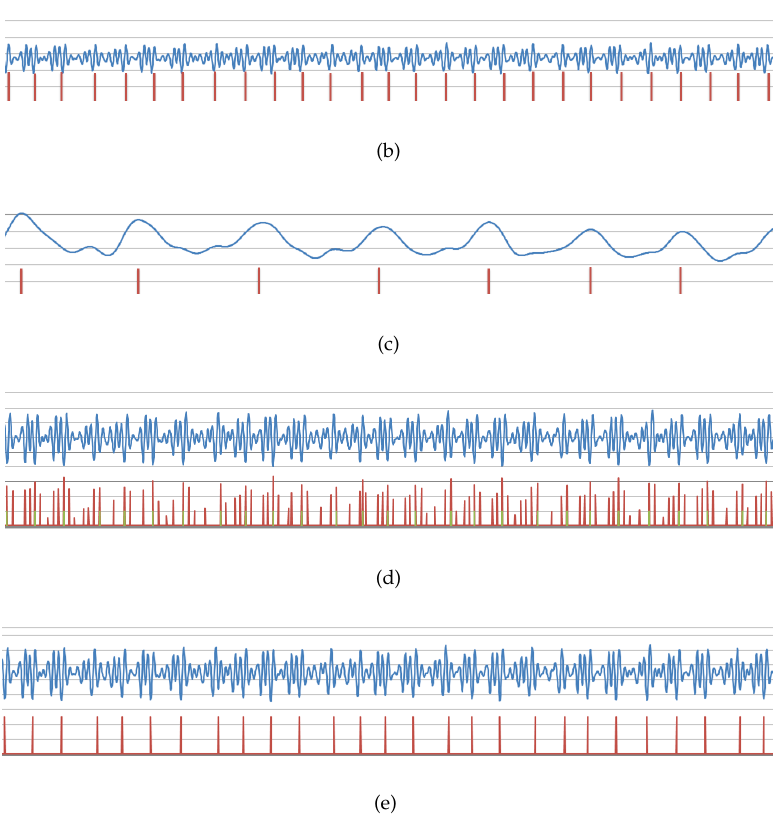
Figure 7. Heart rate variability and respiratory rate. ( a ) Raw data obtained from ADC (100 samples/s, 12-bit resolution); ( b ) Filtering data using an infinite impulse (IIR) filter for estimating the heart rate; ( c ) Filtering data using an infinite impulse (IIR) filter for estimating the respiratory rate; ( d ) Heart peak obtained from filtering data after noise reduction; ( e ) Selected heart peak.